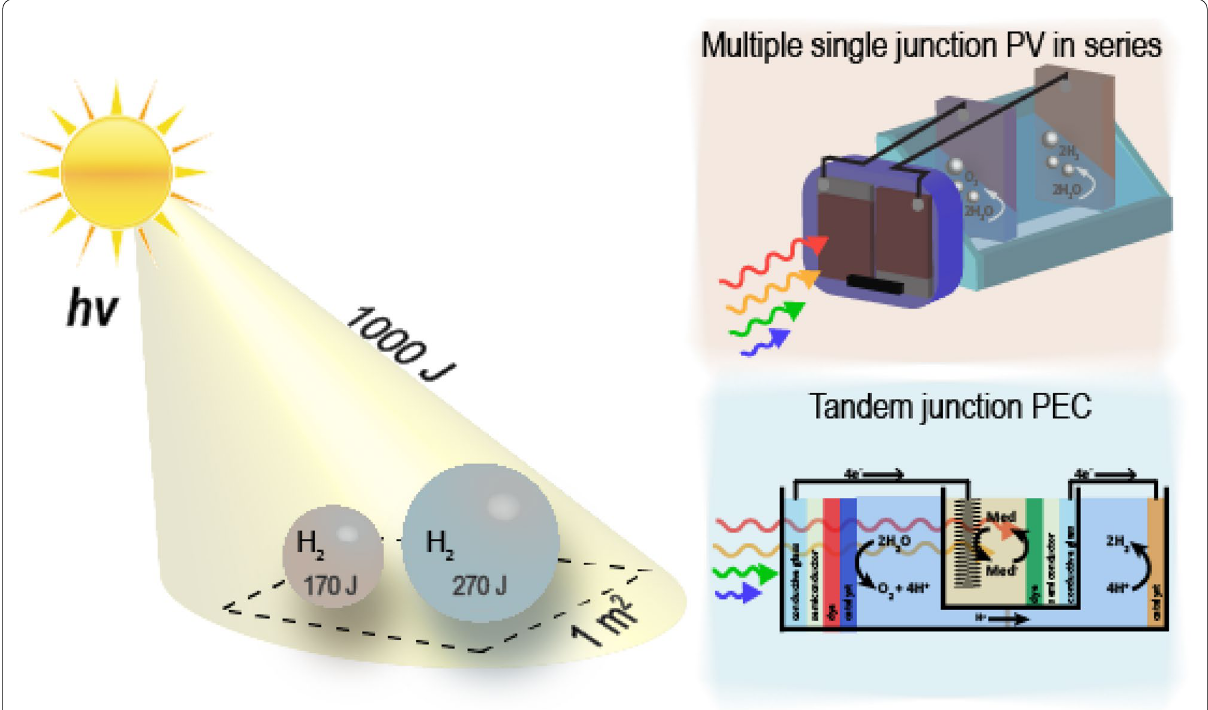
Fig. 1 Comparative optimal energy conversion efficiency for AM 1.5 G solar illumination integrated over a 1 s timescale for a single junction (red shaded sphere) or tandem junction (blue shaded sphere) photoelectrochemical cell. The right panels provide example device architecture for a single junction (no change to overall optimum efficiency for multiple single junction devices mounted in parallel to the light source) and tandem DSPEC-DSSC water splitting